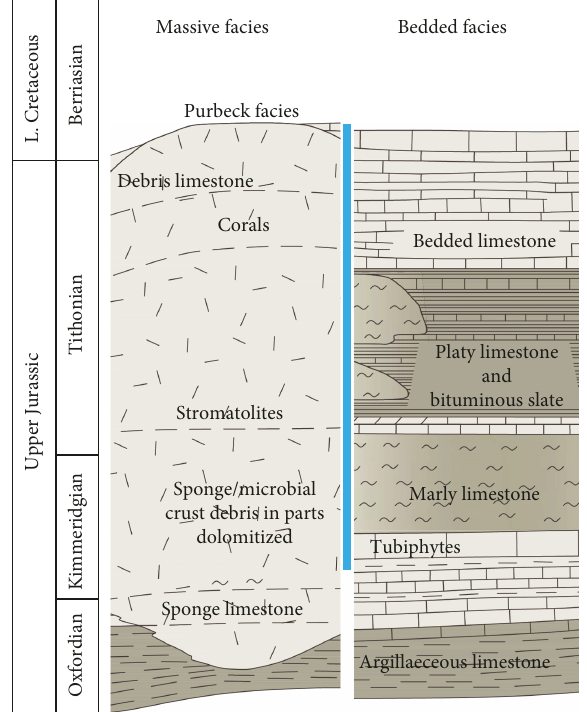
Figure 3: Schematic stratigraphic column of the Upper Jurassic strata in the Molasse Basin in southern Germany. The blue column shows the sample area of this